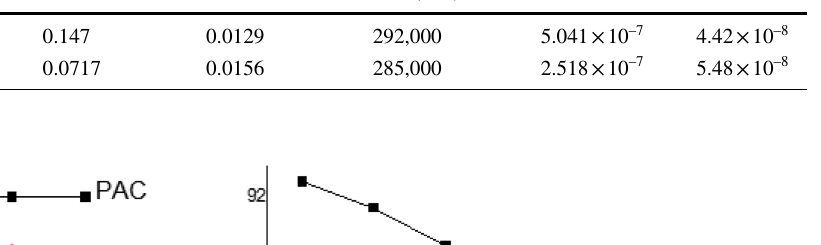
transfer constant derived from Fig. 3